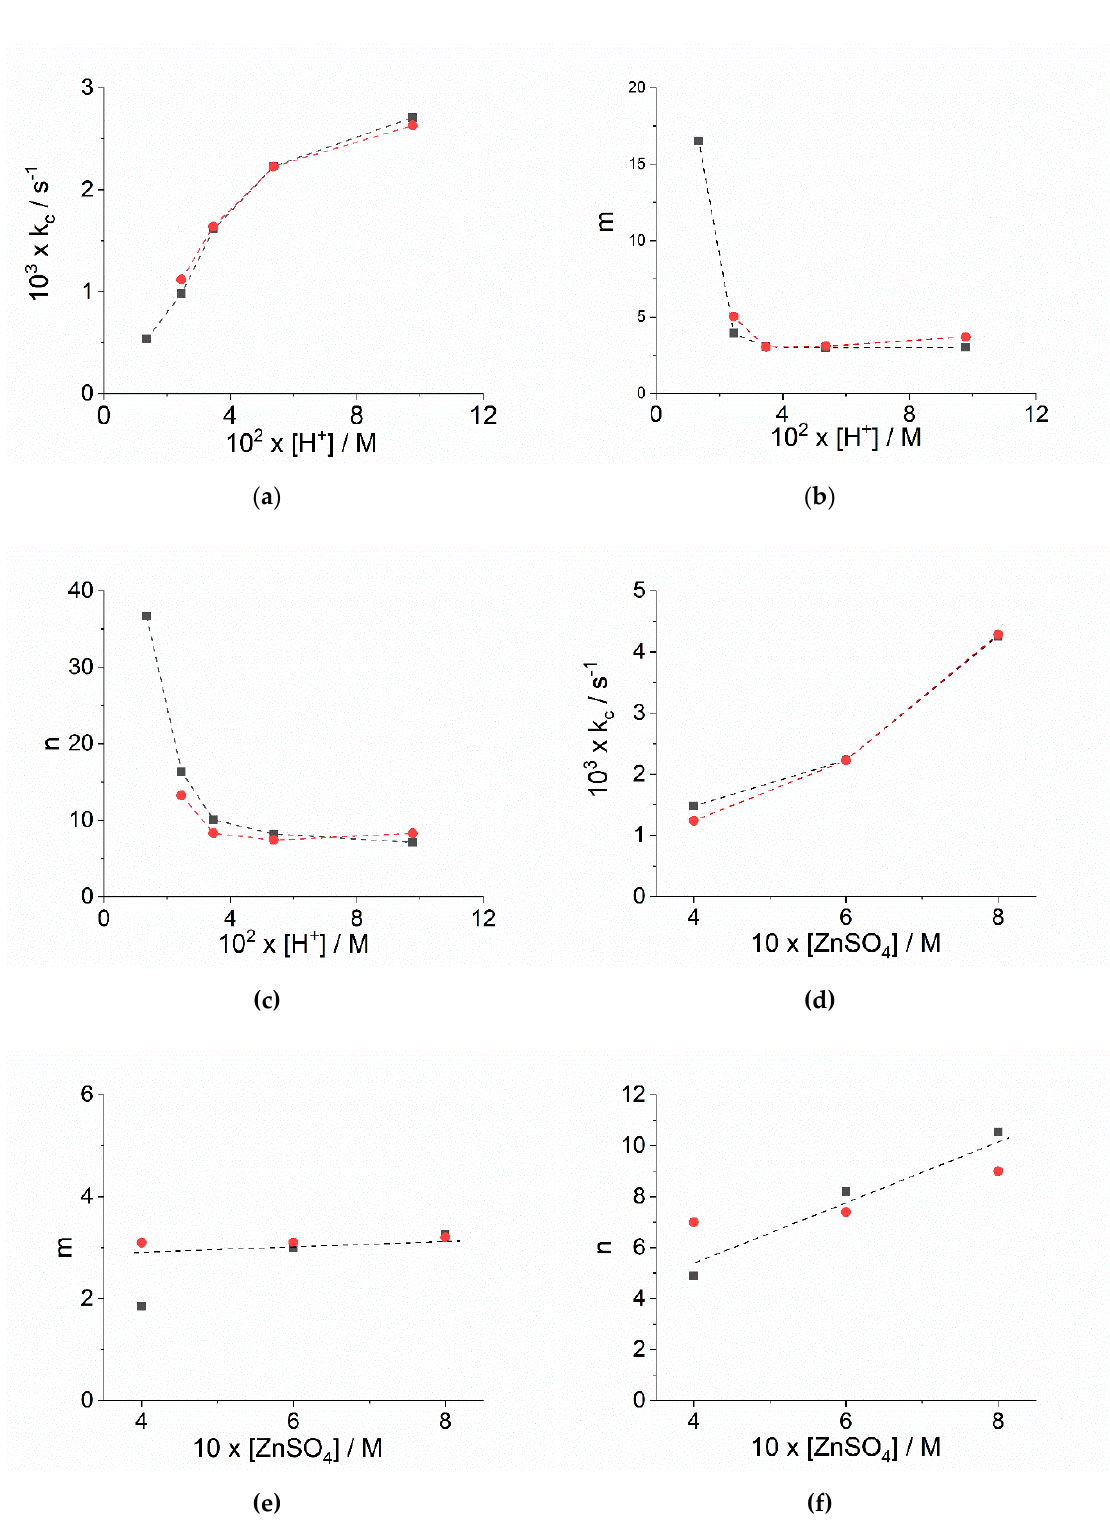
Figure 5. Plot of ( a , d ) the rate constants k c (s − 1 ); ( b , e ) the size of the critical nucleus, m ; and ( c , f ) the time exponent n for the catalyzed growth of J-aggregates as function of [H + ] at constant ionic strength (upper plots) and as function of [ZnSO 4 ] at constant pH ([H 2 SO 4 ] = 0.05 M) (lower plots) (black and red data refers to analysis at 490 nm and 434 nm, respectively).